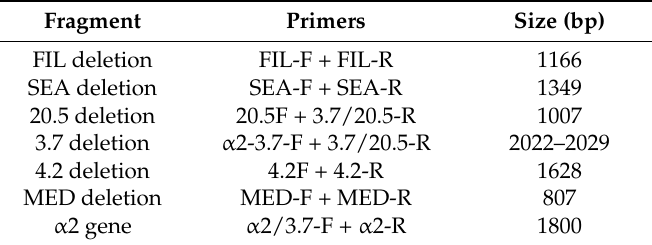
Table 8. Combinations of primers to detect each